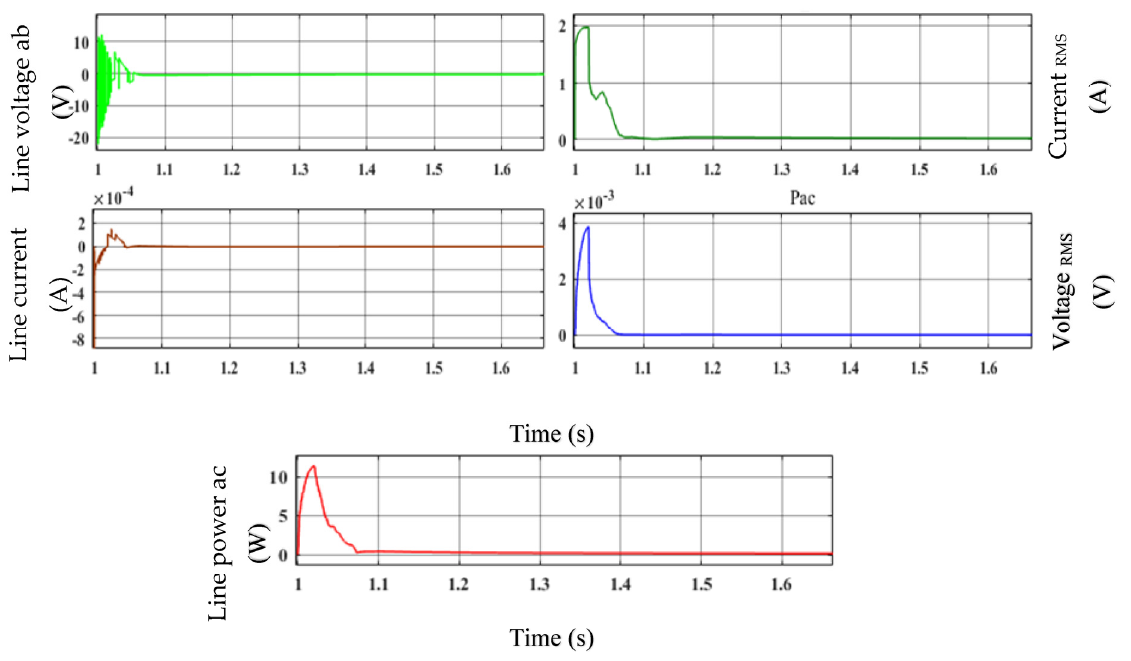
Figure 10. Performance of the EFLC: line voltage, line current, voltage RMS, current RMS, and power Pac.